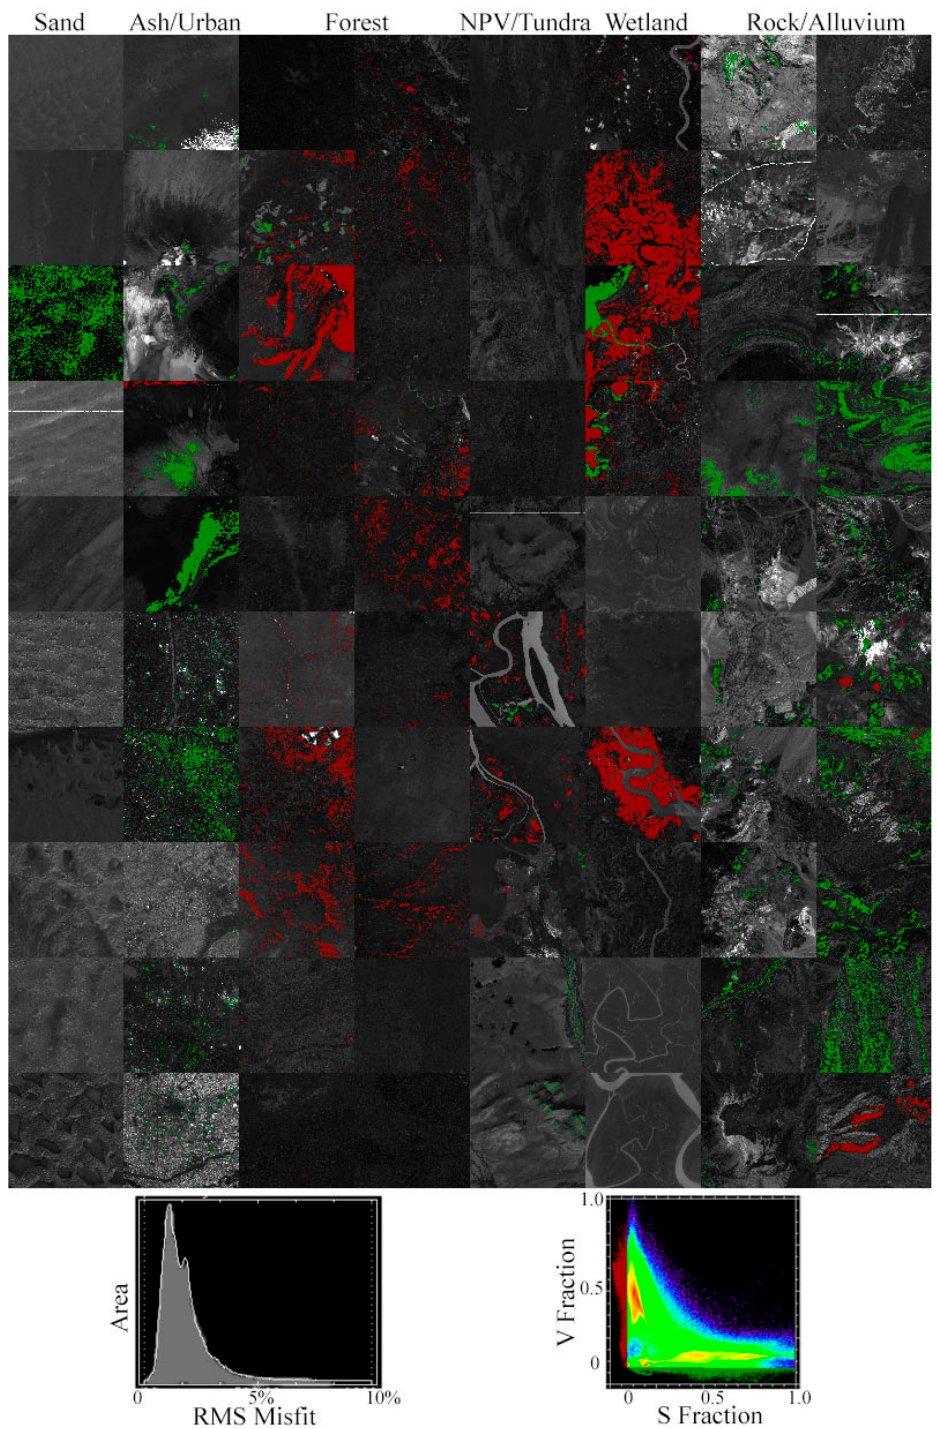
Figure 6. SVD model misfit and negative fraction distributions. RMS misfit map (linear stretch [0, 10%]) shows largest misfits associated with snow, evaporites and turbid water. RMS distribution shows 99% of spectra with < 5% misfit (92% < 3%). Negative S (red) and V (green) fractions are well within 0.1 of zero.